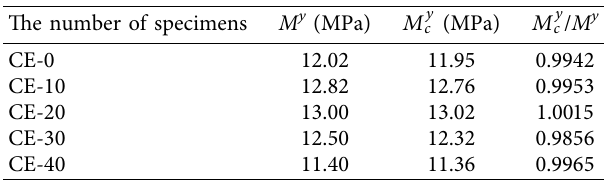
Figure 12: Polynomial ftting curve of ultimate bearing capacity of concrete beams with diferent replacement rates of graphite tailings after chloride erosion. Table 5: Comparison of experimental and computational results according to formula